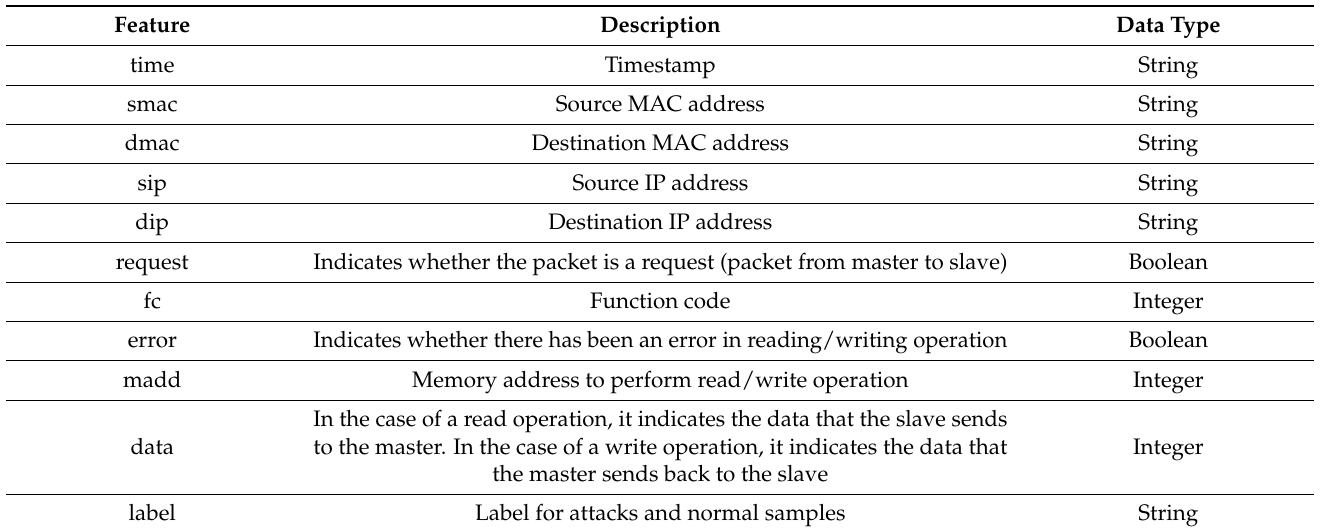
Table 1. Descriptions of the Electra Modbus dataset